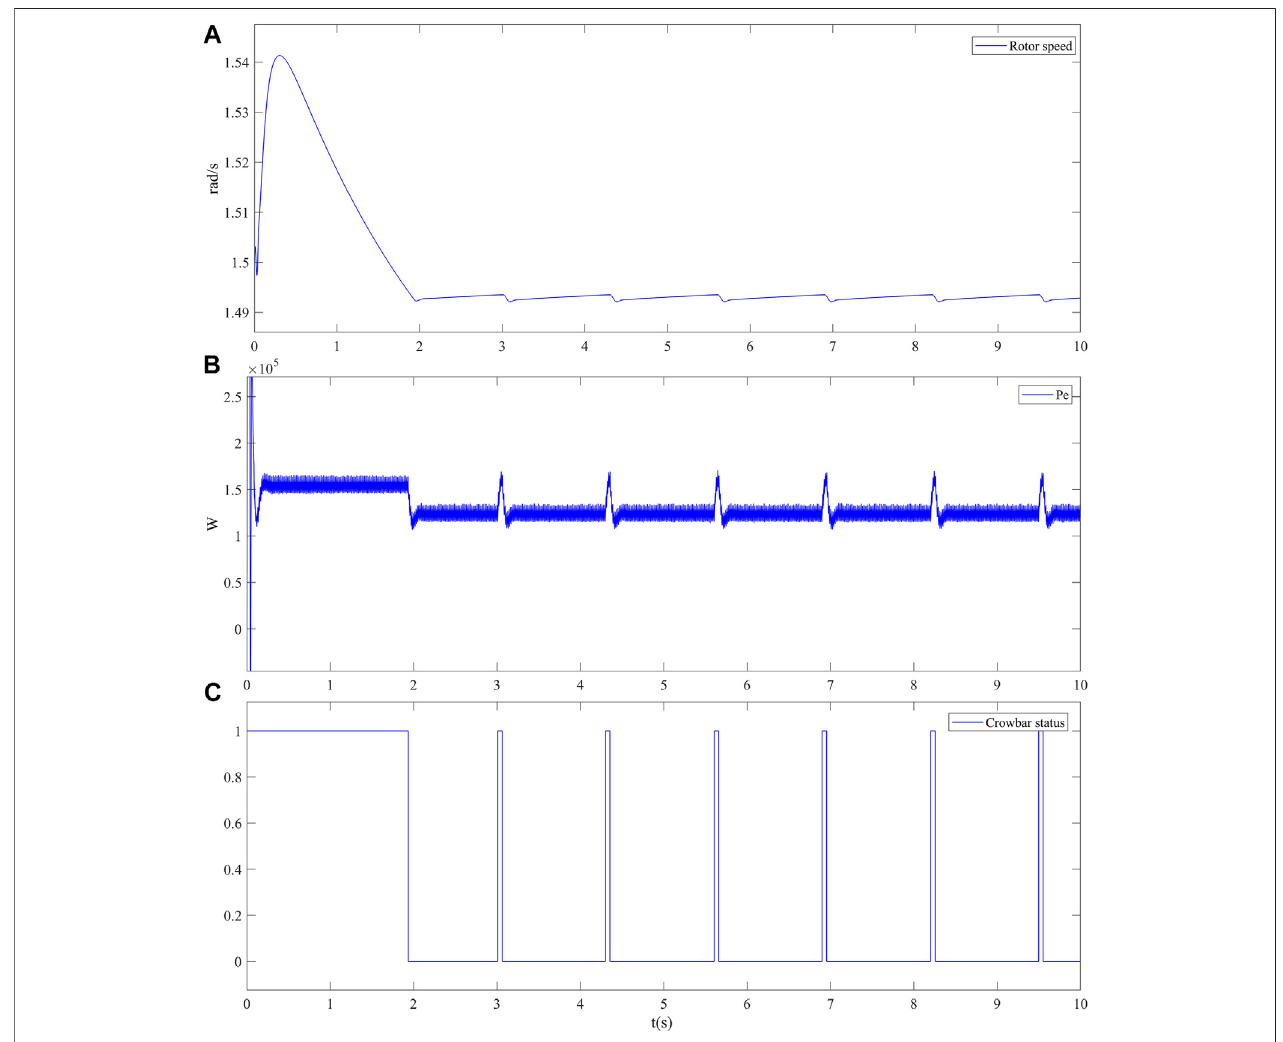
FIGURE 9 | The rotor speed, electrical power, and crowbar status in case 1. (A) The rotor speed (B) Electrical power Pe (C) Crowbar status.